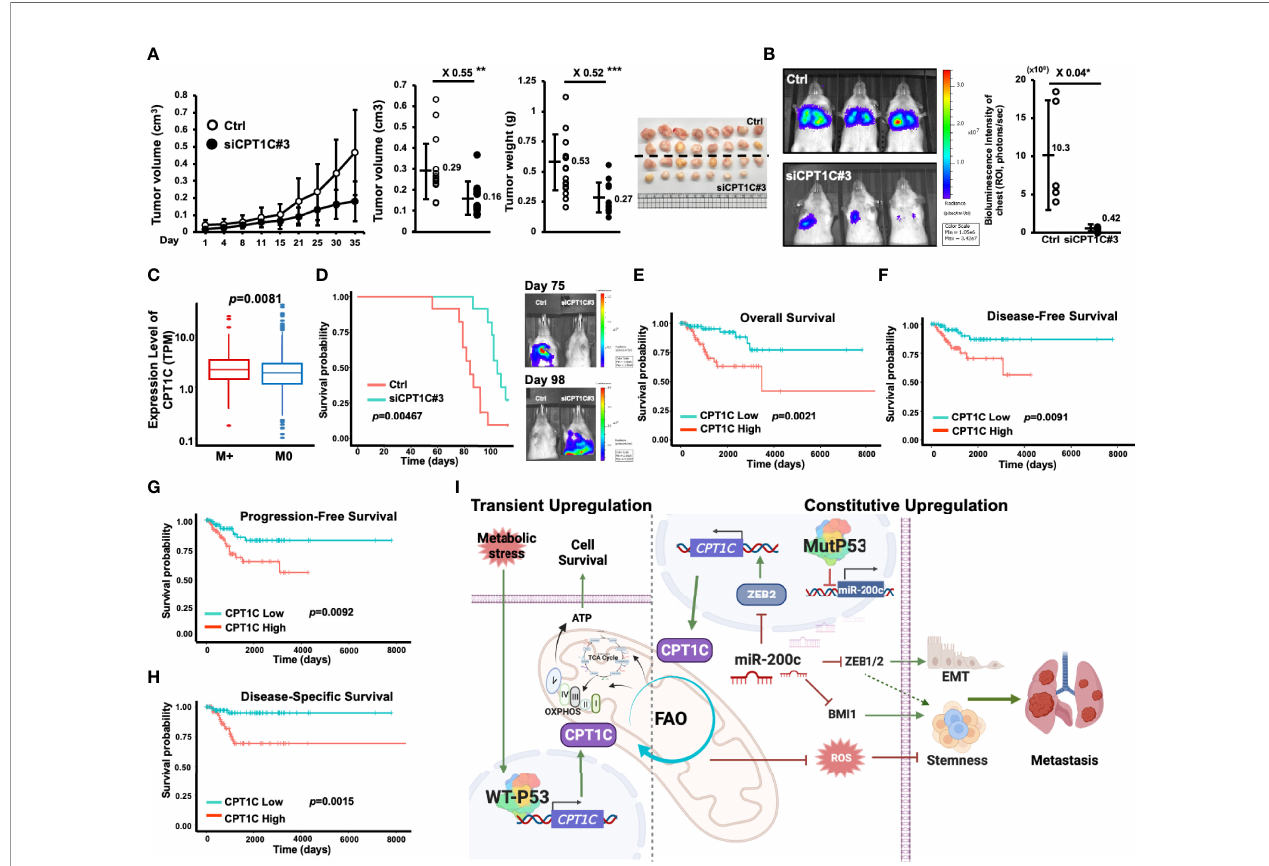
FIGURE 7 | High CPT1C expression is associated with poor prognosis in basal-like breast cancer patients. (A) Interfering with CPT1C expression attenuates the growth of BLBCs in vivo . MDA-MB-231-Ctrl (n = 16) and MDA-MB-231-siCPT1C#3 (n = 15) cells (3x10 6 ) were inoculated into the fourth mammary fat pad of SCID mice for fi ve weeks. Tumor sizes were recorded at indicated days and plotted as a growth curve. At day 35, tumors were harvested surgically, tumor weights were measured, and tumor volumes were determined with the formula: (d1x d2 2 )/2 (d1: larger diameter; d2: smaller diameter) and plotted as dot plots (mean ± SD). The two sides of the lines above the dots indicated the comparison of the CPT1C-KD group to the control group, and the value offold changes with the asterisks representing signi fi cance was marked above the line. Data were analyzed by unpaired t-test. **p < 0.01; ***p <0.001. (B) Interfering with CPT1C expression suppresses the pulmonary metastasis of BLBCs in vivo. MDA-MB-231- Luc2-Ctrl (n = 5) and MDA-MB-231-Luc2-siCPT1C#3 (n = 5) cells (1x10 6 ) cells were inoculated into NOD-SCID mice through lateral tail-vein injection. At fi ve weeks post- injection, an IVIS imaging was carried out to examine the pulmonary colonization of MDA-MB-231 cells. Left: Representative images of MDA-MB-231-Luc2